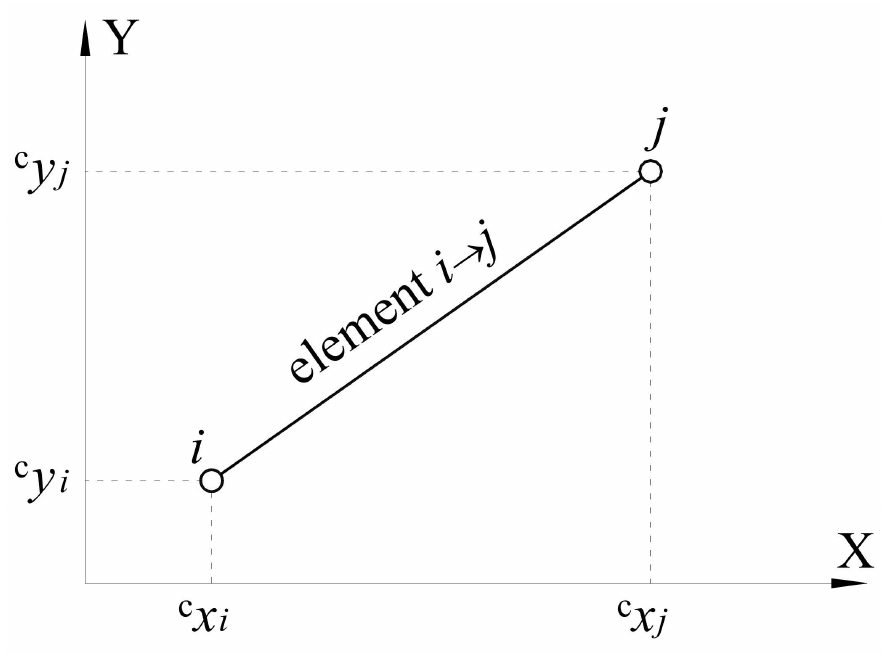
Figure 1. Definition of a truss